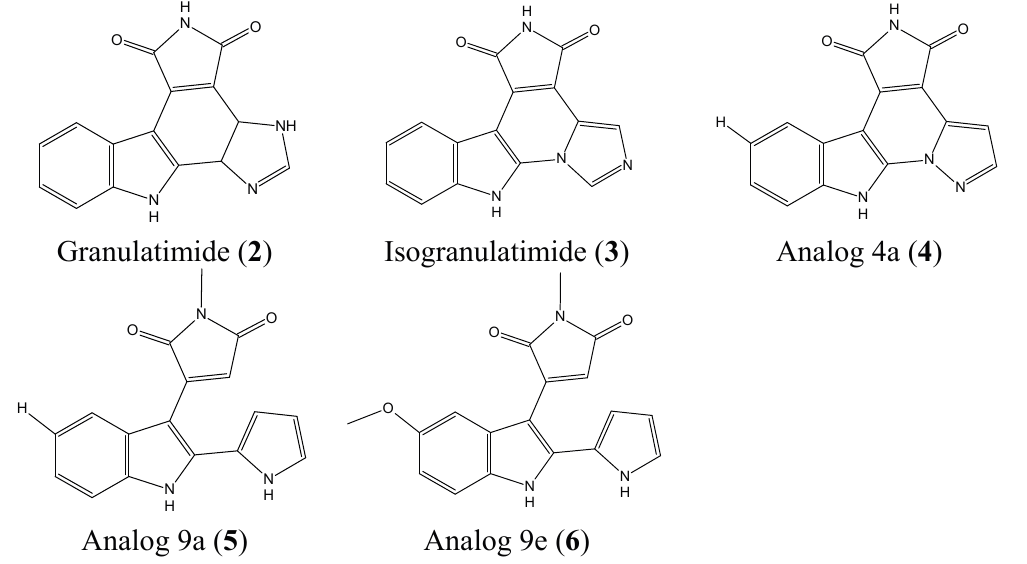
Figure 2. Chemical structure of granulatimide, isogranulatimide, and their